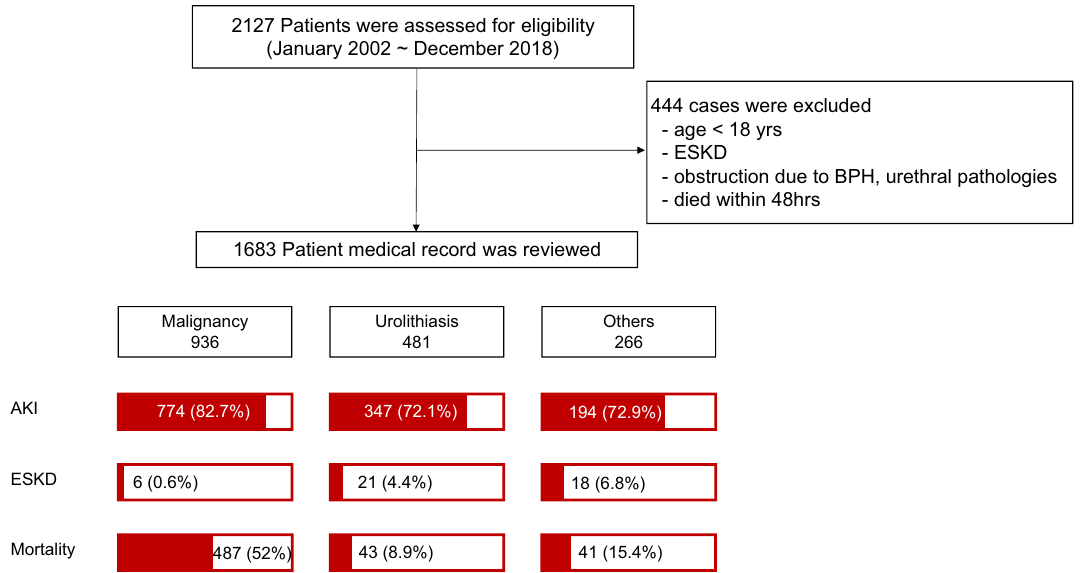
Figure 1. Enrollment and outcomes. Among 2127 patients who underwent PCN for obstructive uropathy between January 1, 2002 and December 31, 2018, in three tertiary hospitals were assessed for the inclusions, patients were excluded and finally 1683 patients were enrolled for assessment. According to PCN divided into three etiologies, the short-term renal outcome, long term renal outcome and all-cause mortality were